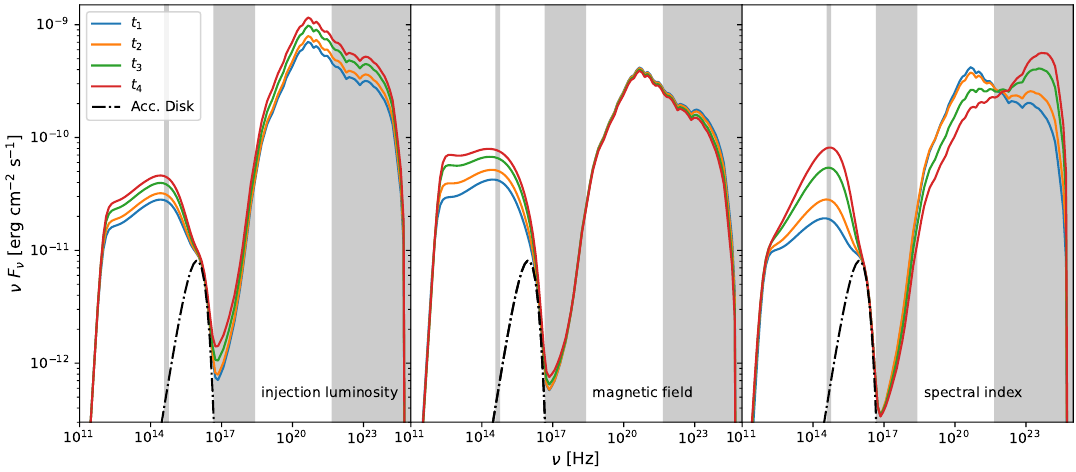
Figure 4. Snapshots of the SED during the seed variation in Figure 2 at times of an increase in injection luminosity ( left ) and magnetic field ( middle ), as well as a hardening of spectral index ( right